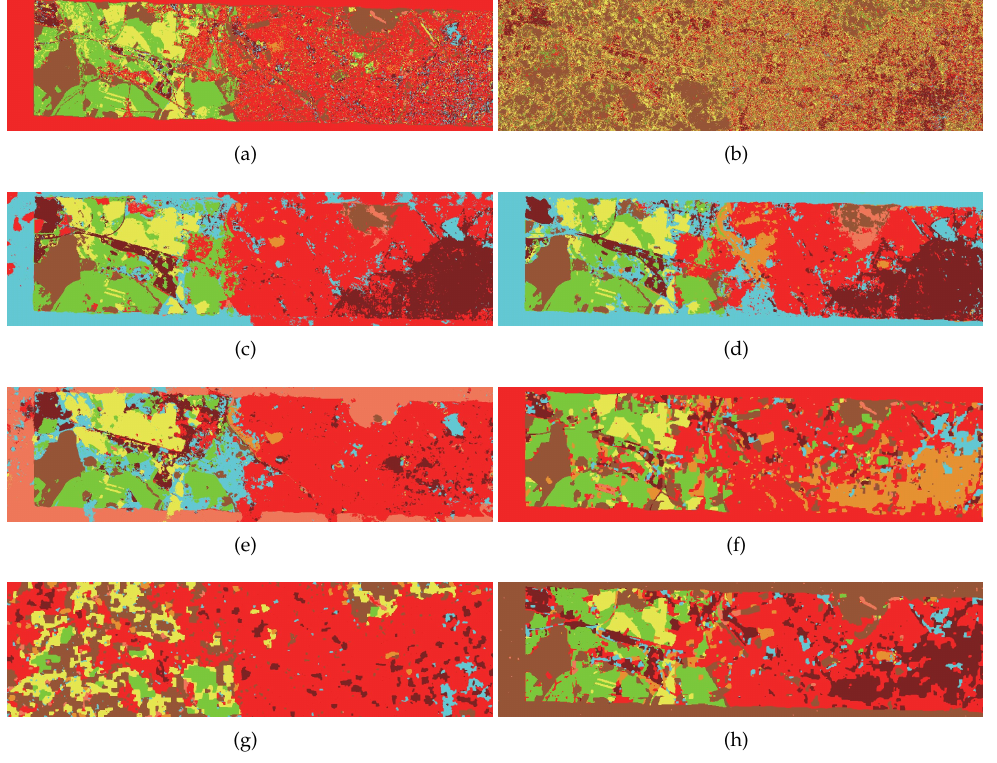
Figure 6. Visual maps obtained by different approaches on Berlin dataset. ( a ) MLR on HSI. ( b ) MLR on SAR. ( c ) OTVCA. ( d ) SSLRA. ( e ) SubFus. ( f ) Our method on HSI. ( g ) Our method on SAR. ( h ) Our